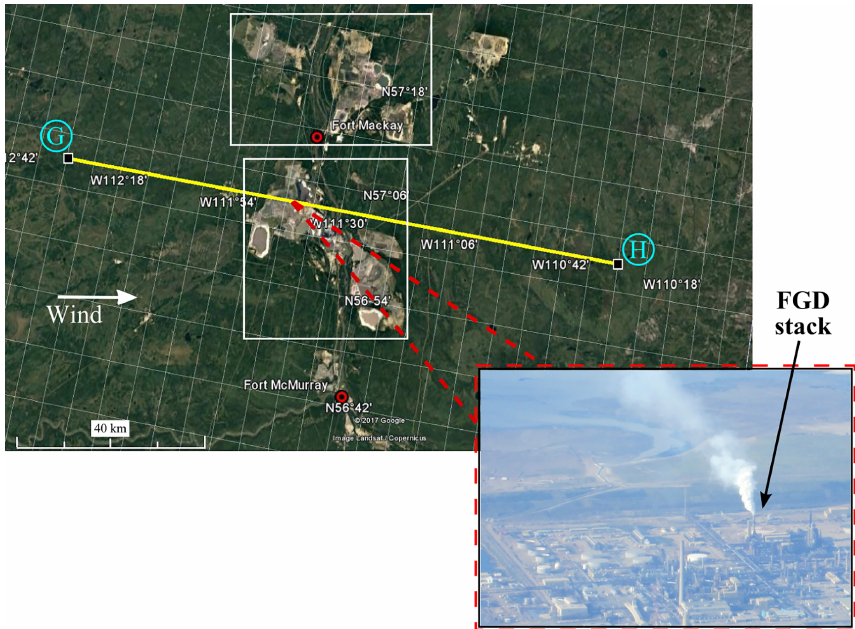
Figure 6. The flight segment G–H on 23 August 2013 (13:04 to 13:26 local time (UTC − 6h) displayed on Google Earth. Point G represents the starting position of the flight leg and point H the ending position. The oil sands industry was contained within the regions outlined in white. The average direction of the wind at height of 800ma.s.l. on 23 August 2013 at the measurement time is indicated by the arrow. Inset photo shows the area that was flown over, including the flue-gas desulfurization (FGD) stack.